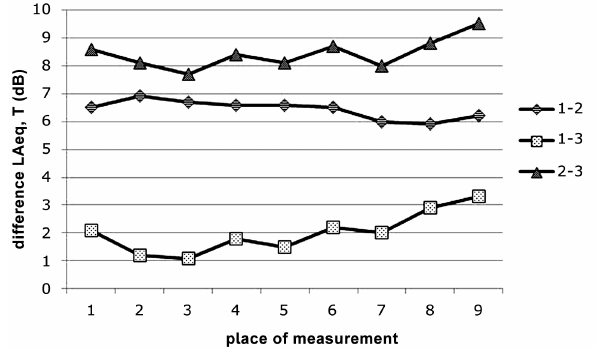
Figure 2. Difference in noise levels between different times and measurement places. Period: 1 – time before feeding; 2 – feeding time; 3 – time after feeding; 1–2 – difference between periods 1 and 2; 1–3 – difference between periods 1 and 3; 2–3 – difference between periods 2 and